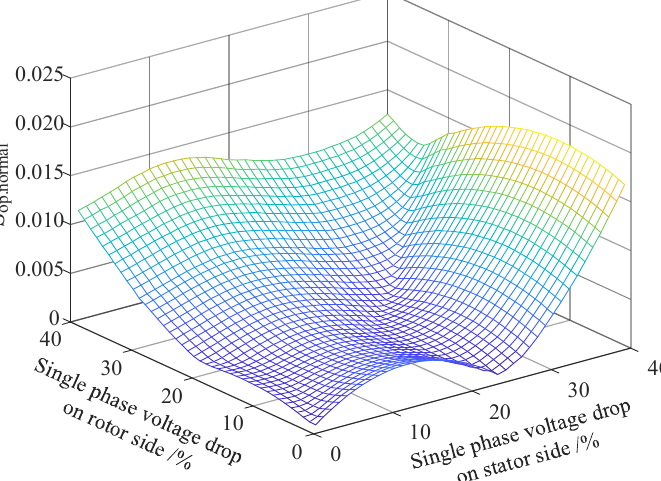
Figure 5. The action value S op . normal with different phase voltage drops when the slip ratio s is 0.1.